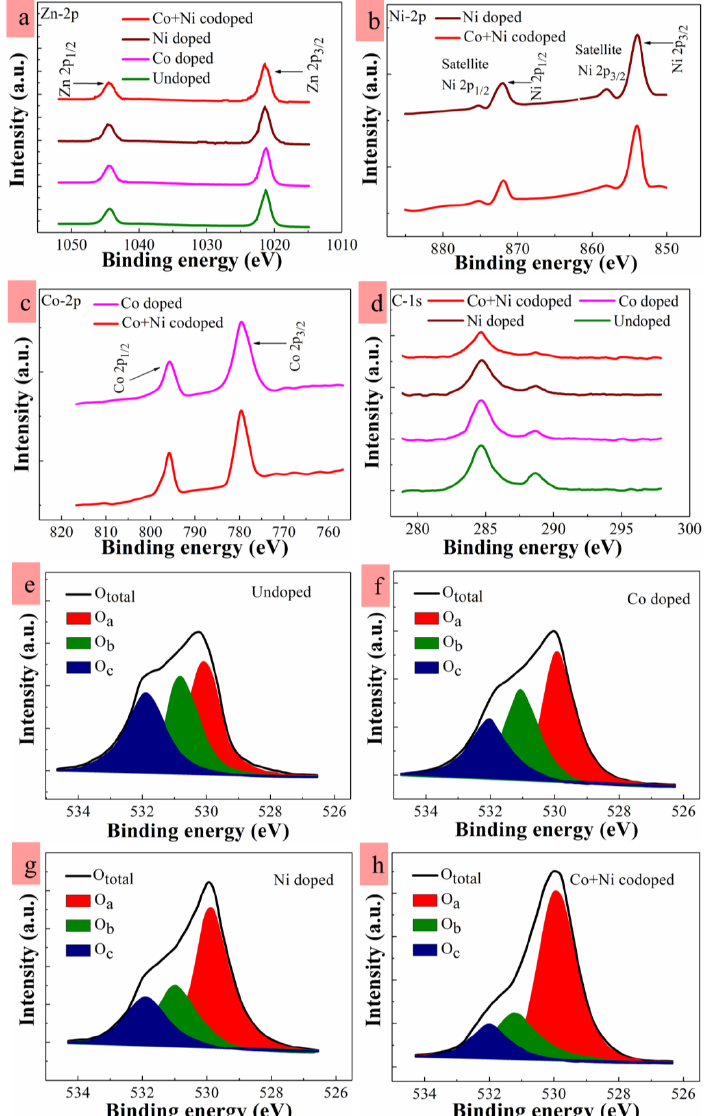
Figure 5. High-resolution X-ray photoelectron spectroscopy (XPS) spectra of ( a ) Zn-2p, ( b ) Ni-2p, ( c ) Co-2p, and ( d ) C-1s of ZnO NRs. Deconvoluted O1s core level spectra into three satellite peaks obtained from ( e ) undoped, ( f ) Co-doped, ( g ) Ni-doped, and ( h ) Co-plus-Ni codoped ZnO NRs.